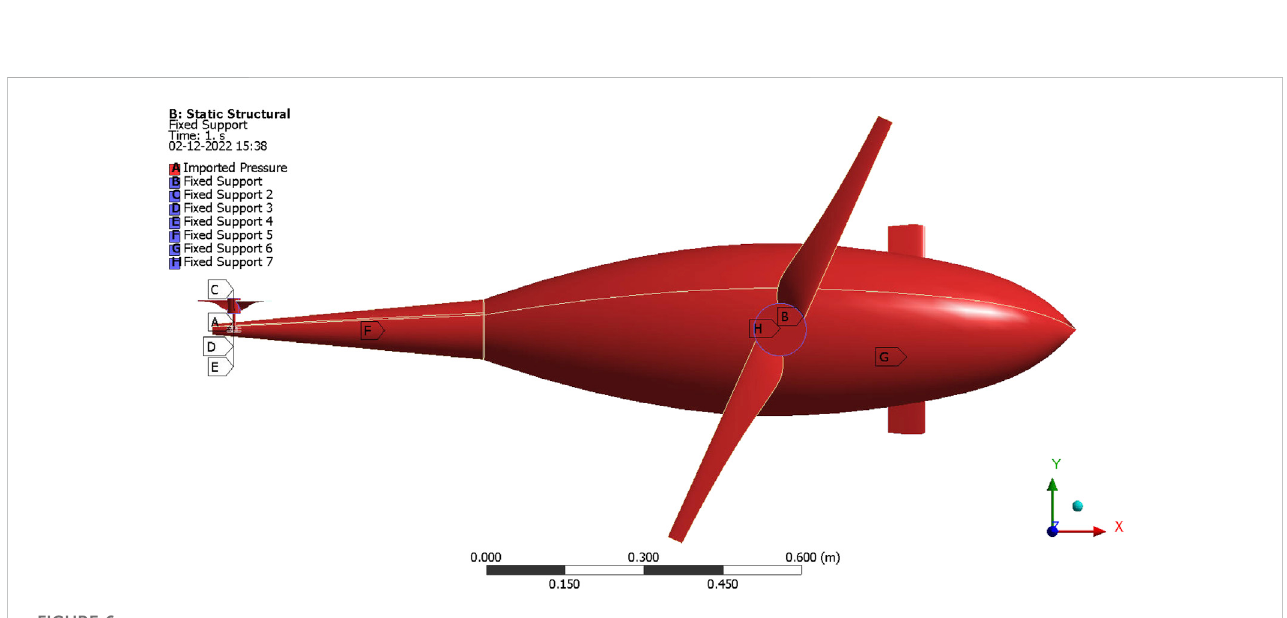
Imposed boundary conditions on